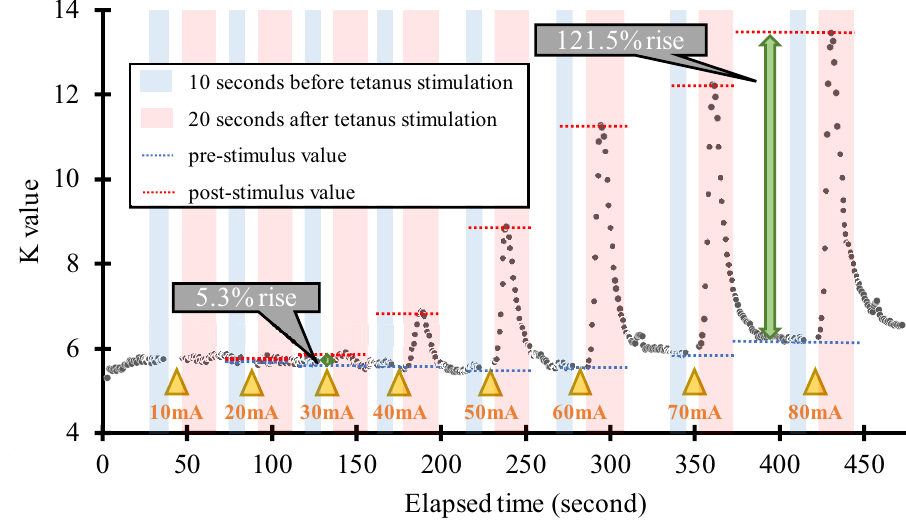
Figure 2. Schema describing minimum evoked current (MEC) measurement in the study. An example of variation in vascular stiffness value (K) during tetanus stimulation. The predicted effect-site concentration of remifentanil was maintained at 2 ng/ml throughout the study. In the figure, △ indicates the timing of tetanus stimulation, which was incrementally increased by 10 mA. The rate of K change increased with increasing stimulus intensity. In this case, the first time the rate change of K exceeded 5% was after 30 mA stimulation (MEC K = 30 mA). The rate of change in K at 80 mA is 121.5%, which is K R80